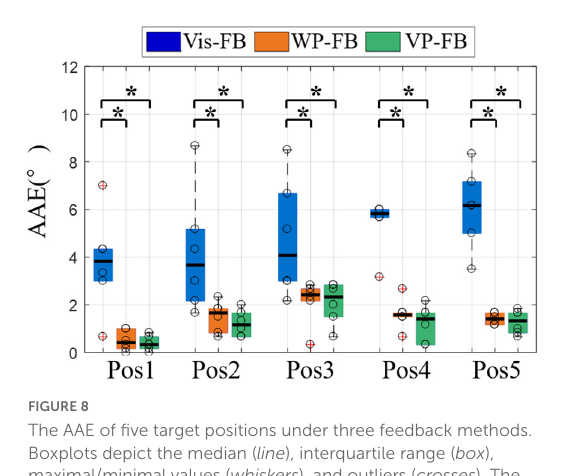
FIGURE8 The AAE of five target positions under three feedback methods. Boxplots depict the median ( line ), interquartile range ( box ), maximal/minimal values ( whiskers ), and outliers ( crosses ). The hollow circle denotes the median AAE of each subject. A star indicates the statistically significant differences (* p < 0.05). AAE, absolute angular error.